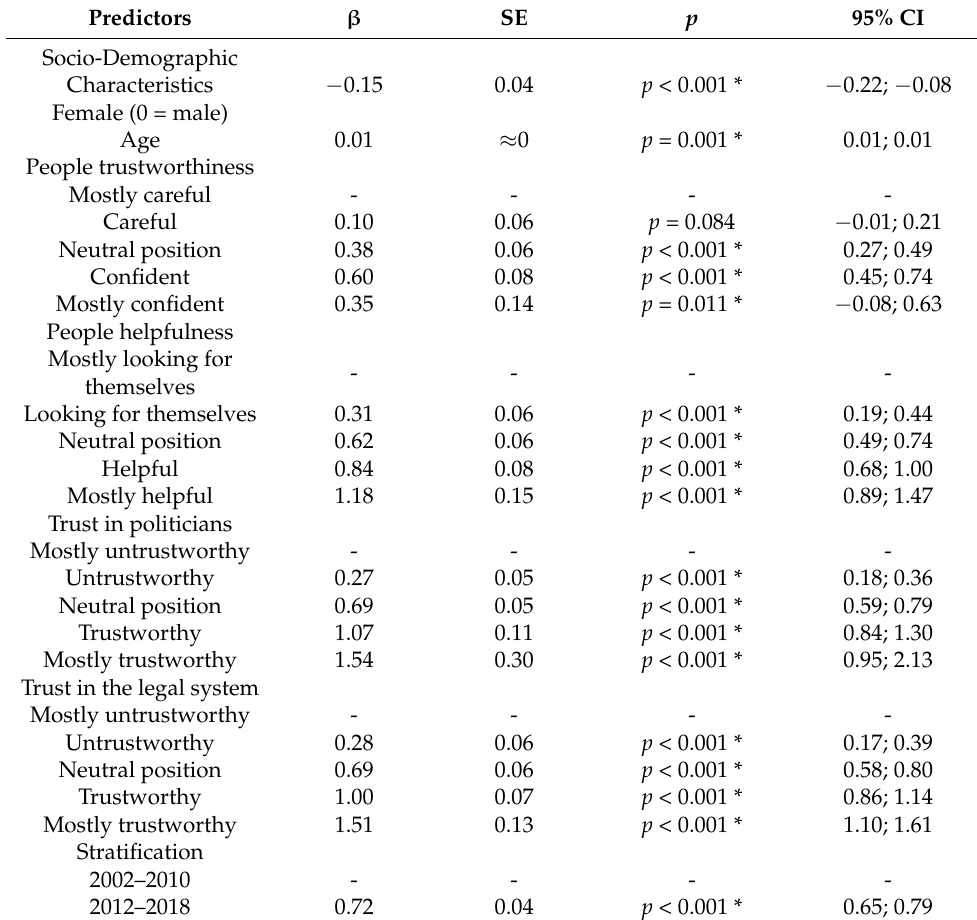
Table 8. Model 4—social trust adjusted for stratification